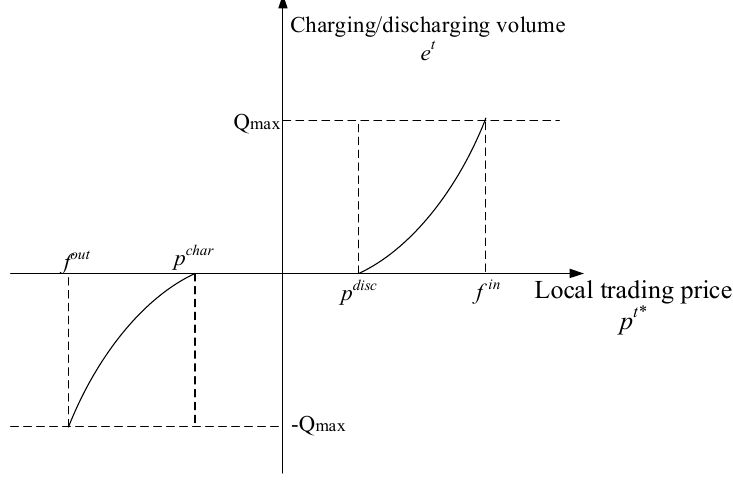
Figure 2. Piece-wise quadratic charging/discharging functions.